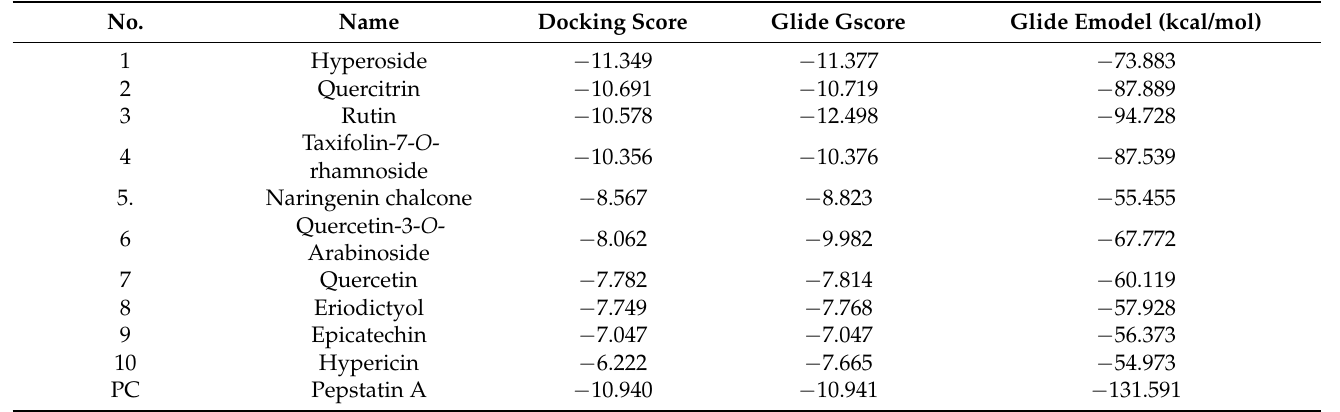
Table 7. Docking of the 10 active compounds in the H. kouytchense insect gall extracts, along with positive control pepstatin A, against HIV-1